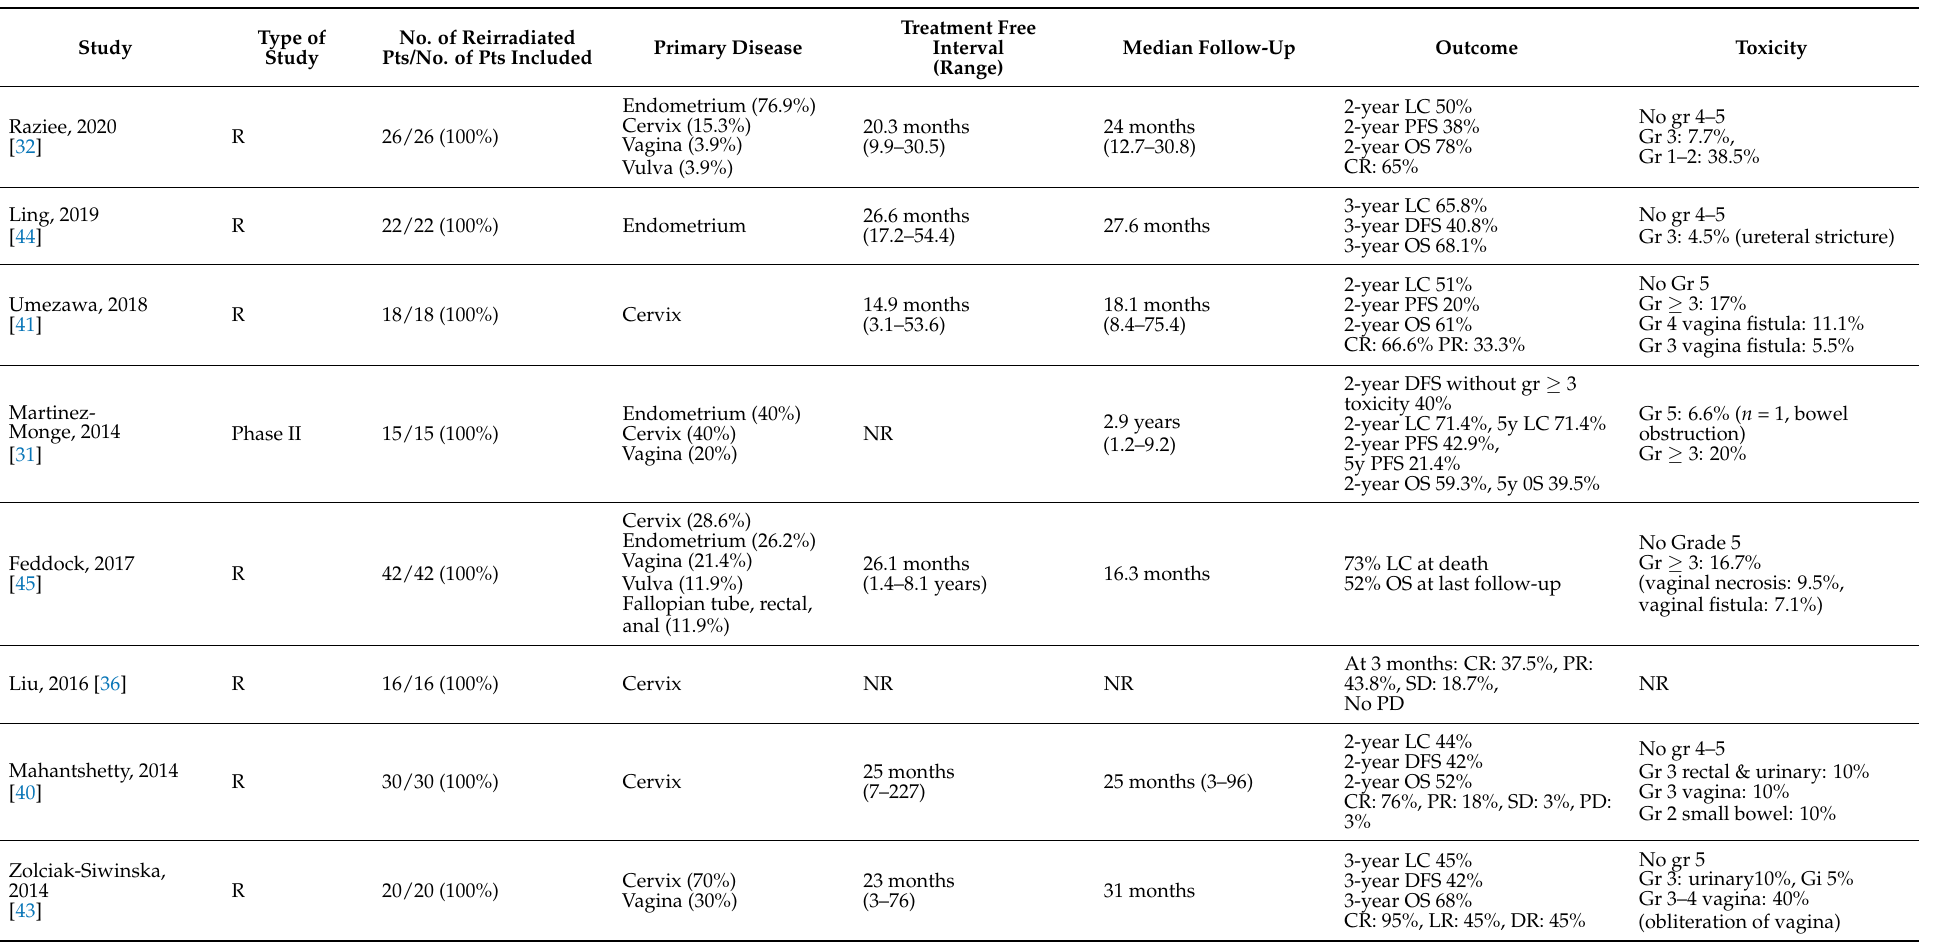
Table 1. Reirradiation three-dimensional image-guided brachytherapy (3D-IGBT) studies: general aspects, outcome, and